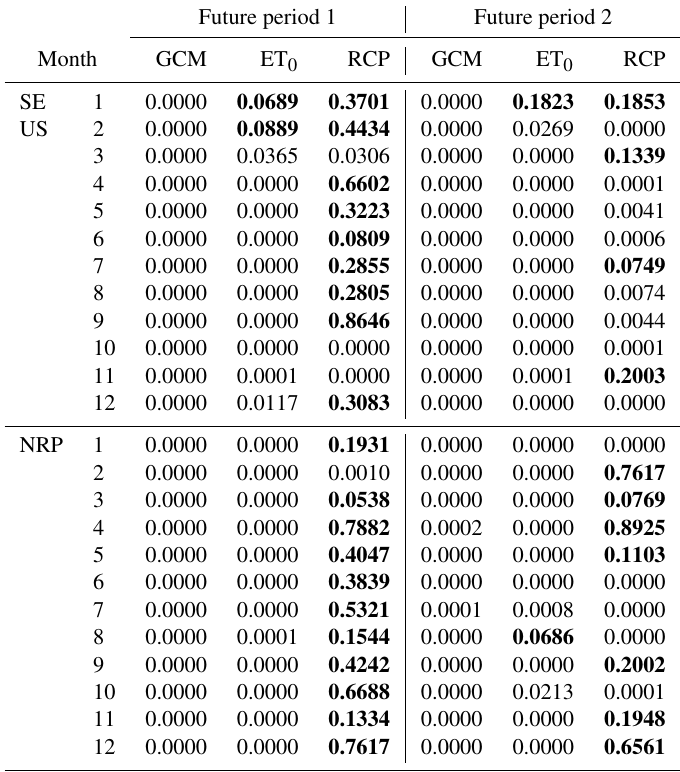
Table 3. P values of a Chi-square two-sample test for differences among wet condition vs. dry condition pdfs: Southeast US (SE US) and Northern Rockies and Plains (NRP; West North Central) US (bold values indicate that pdfs are not statistically significantly different at p = 0.05).